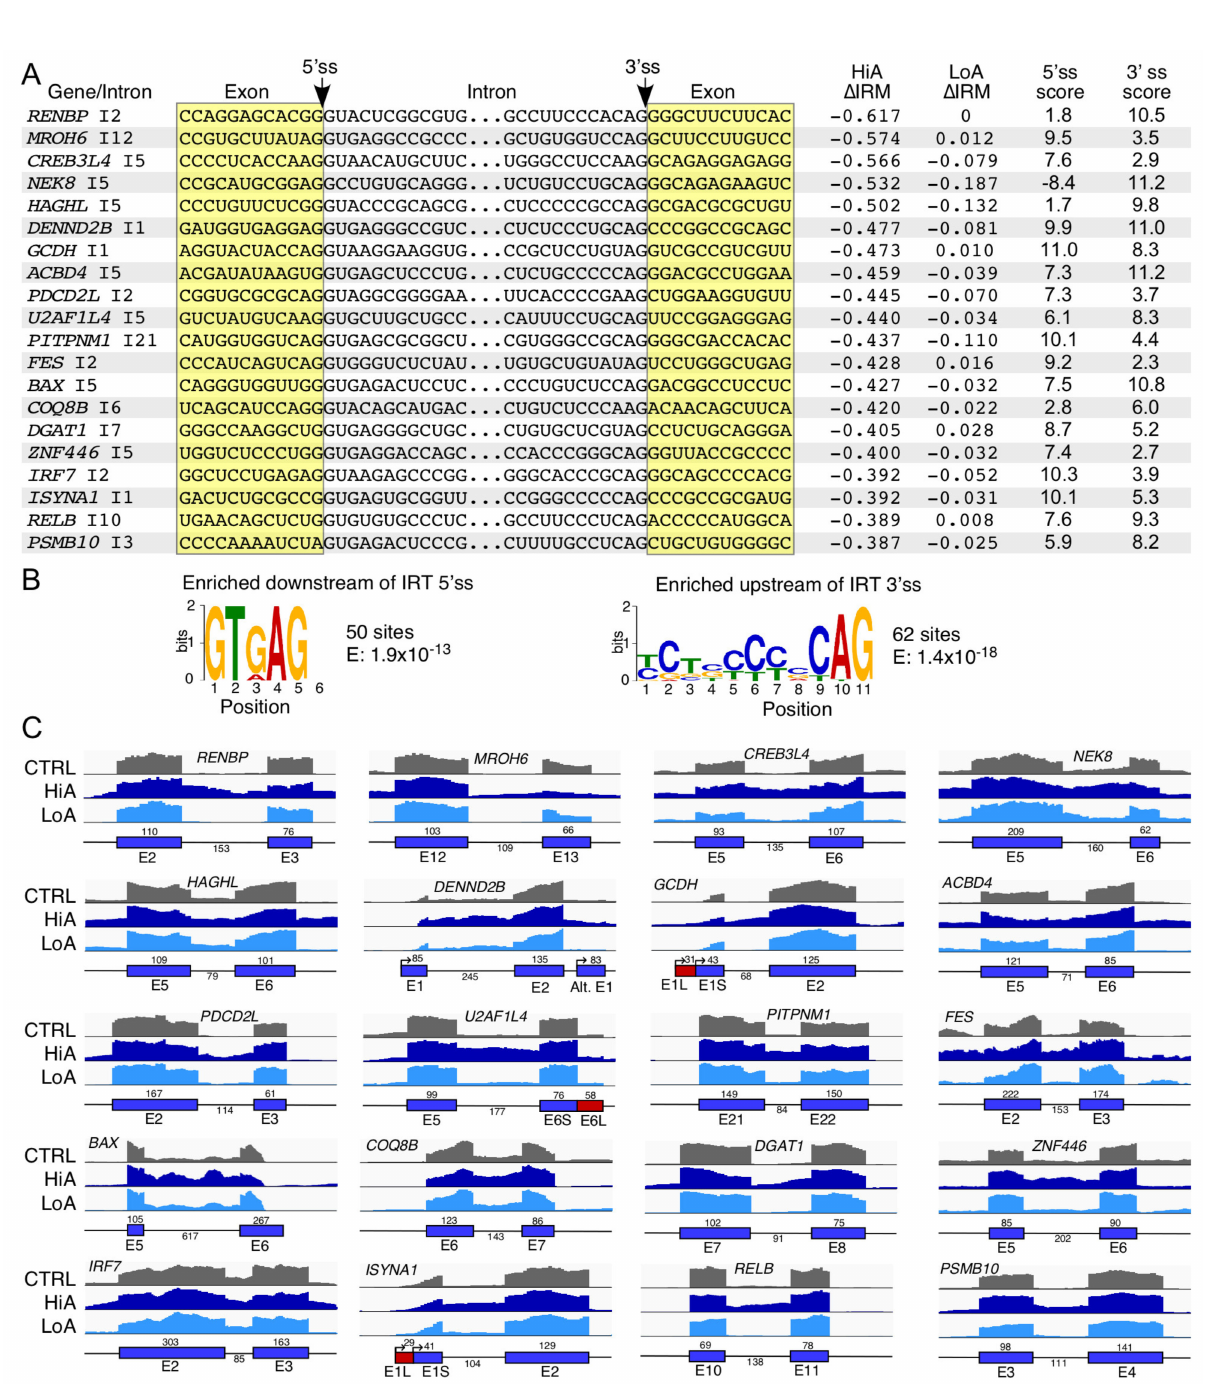
Figure 5. Increased intron retention caused by Anti-N1 treatment. ( A ). The sequence context of 20 candidate introns exhibiting greatly increased retention upon Anti-N1 treatment; 12 nt-long sequences that surround each indicated splice site are shown. ∆ IRM indicates the change in proportional intron removal vs. intron retention. Other table contents and annotation are the same as in Figure 3A. ( B ). Enriched sequence motifs identified by MEME. Left panel: the most enriched motif within 50 nucleotides downstream of the 5 (cid:48) ss of retained introns, which matches the first 5 nucleotides of the consensus 5 (cid:48) ss motif. Right panel: the most enriched motif upstream of the 3 (cid:48) ss of retained introns, which closely resembles the polypyrimidine tract and the 3 (cid:48) ss AG dinucleotide. n = 100 sequences. ( C ). Genomic views of several candidate introns whose retention is increased upon Anti-N1 treatment. Labeling and coloring are the same as in Figure